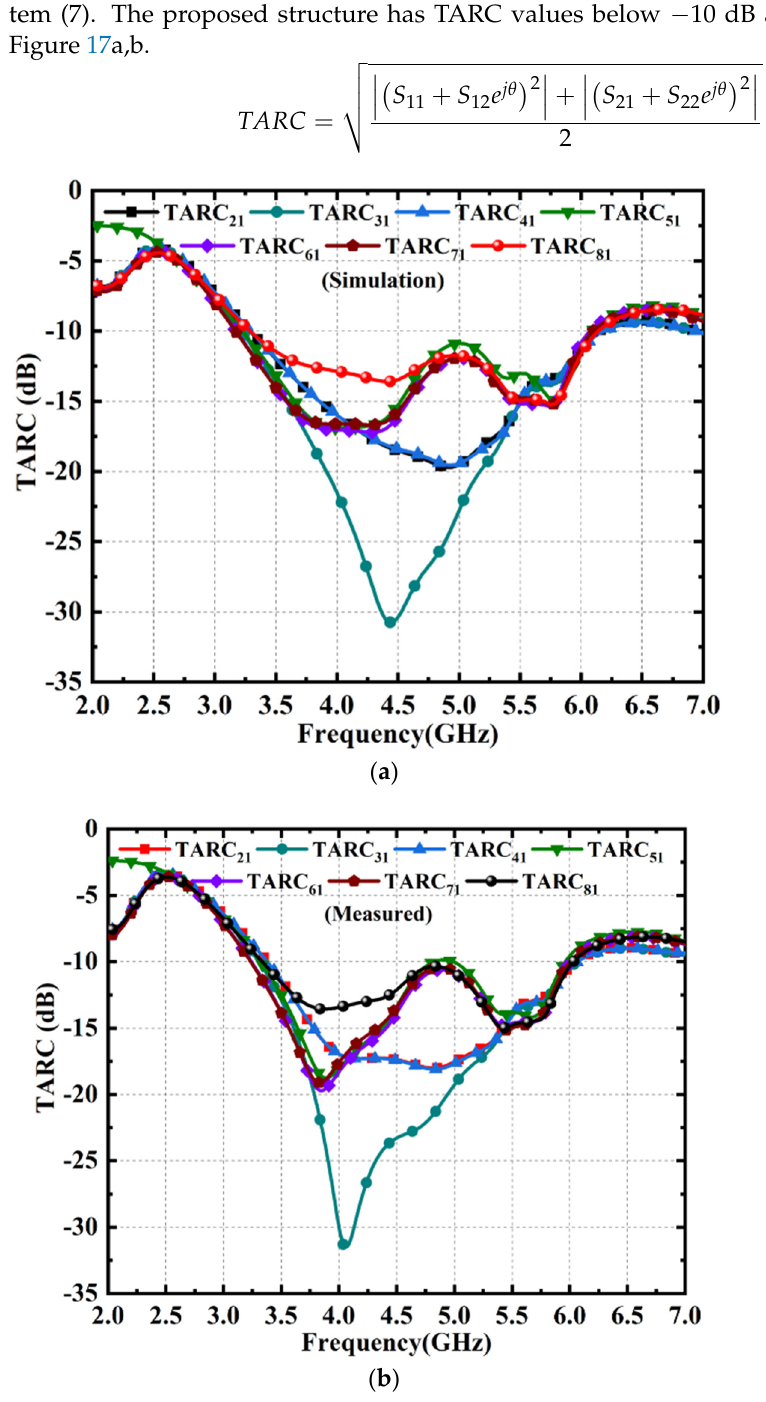
Figure 17. TARC response: ( a ) simulated and ( b ) measured. The channel capacity loss (CCL) defines how many bits are lost when two or more channels transmit signals at the same time. The mutual coupling between antenna elements is one of the main causes of capacity loss. Equations (8)–(10) are used to find the CCL in terms of S-parameters. The simulated and measured CCL plots are given in Figure 18. The proposed design delivers the CCL of <0.02 in the entire band.